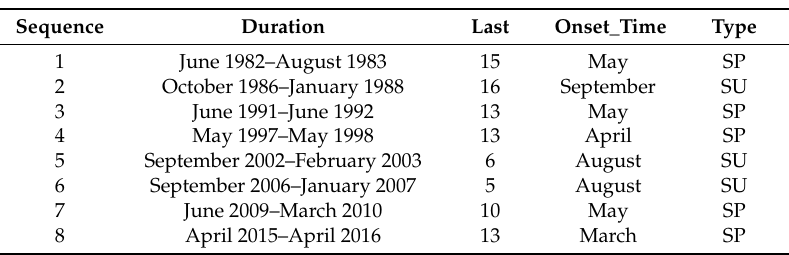
Table 1. Classification of El Niño events during 1979–2016.